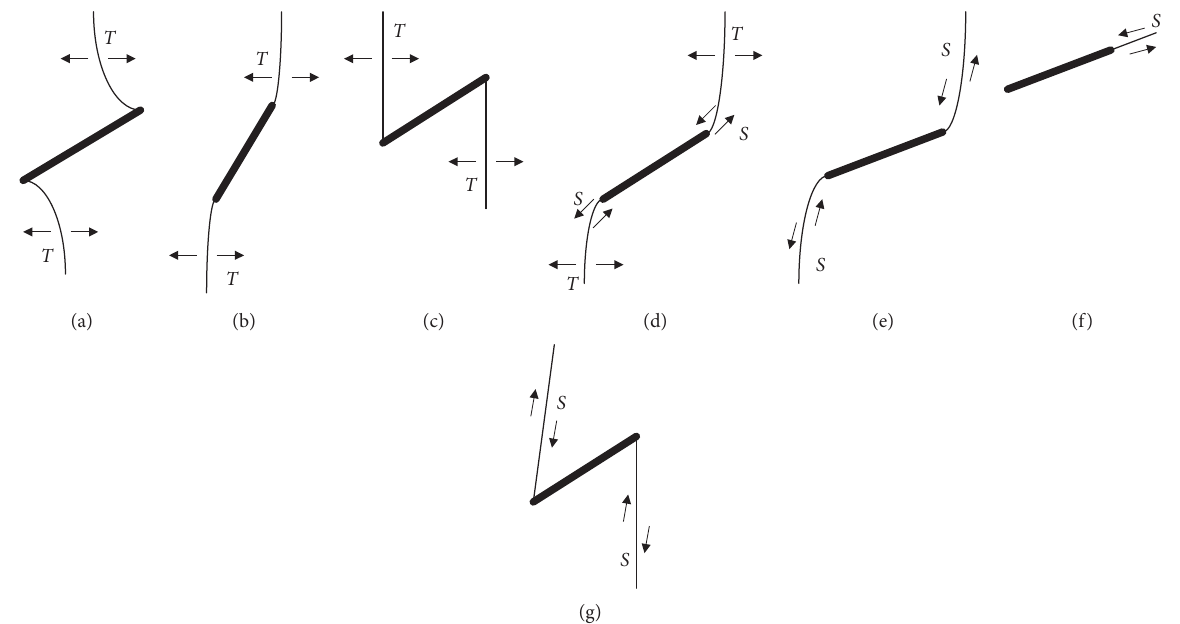
Figure 1: Types of cracks (T-tensile cracks; S-shear cracks). (a) Type 1 tensile crack (tensile wing crack). (b) Type 2 tensile crack. (c) Type 3 tensile crack. (d) Mixed tensile-shear crack. (e) Type 1 shear crack. (f) Type 2 shear crack. (g) Type 3 shear